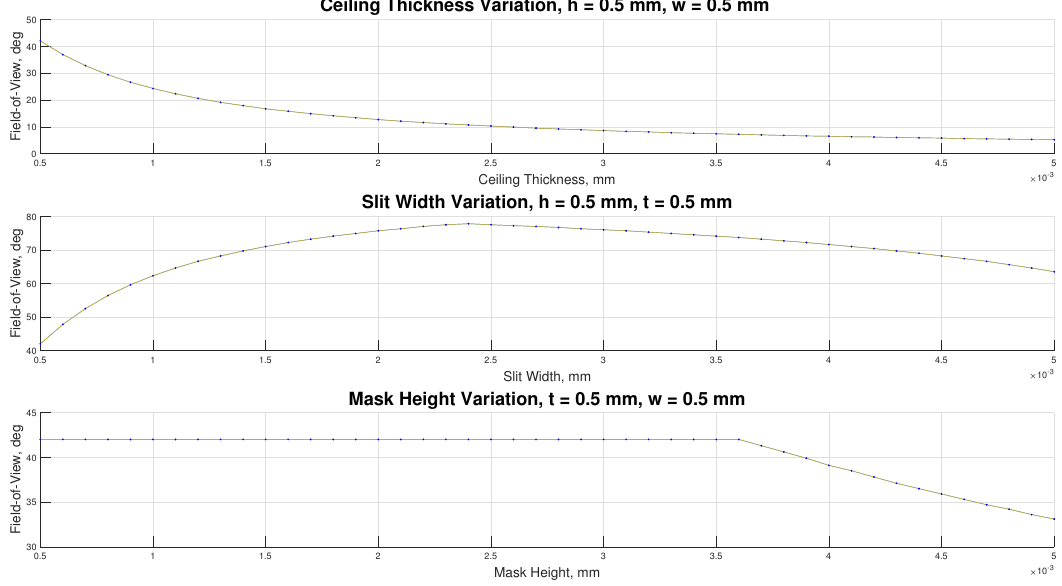
Figure 3. Variations of sun sensor design variables: ceiling thickness, slit width, and mask